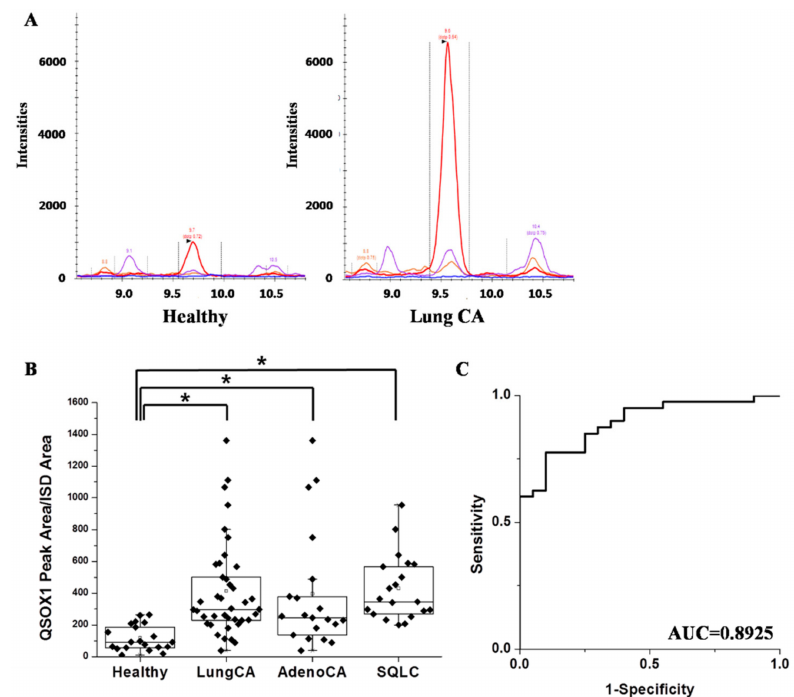
Figure 4. QSOX1 proteins were more abundant in lung cancer patients’ sera compared to those in healthy controls. ( A ) Representative transition peak pattern of QSOX1 peptide, VGSPNAAVLWLWLWSSHNR, in healthy controls and lung cancer patients. ( B ) Box plot showing the normalized measured area of QSOX1 peptide in 20 healthy individuals, 20 adenocarcinoma patients (AdenoCA), and 20 squamous lung cancer patients (SQLC). ( C ) ROC plotted for 60 individuals with the area under curve (AUC) value of 0.8925. (* denotes p < 0.05, compared to healthy individual samples in the analysis of significant